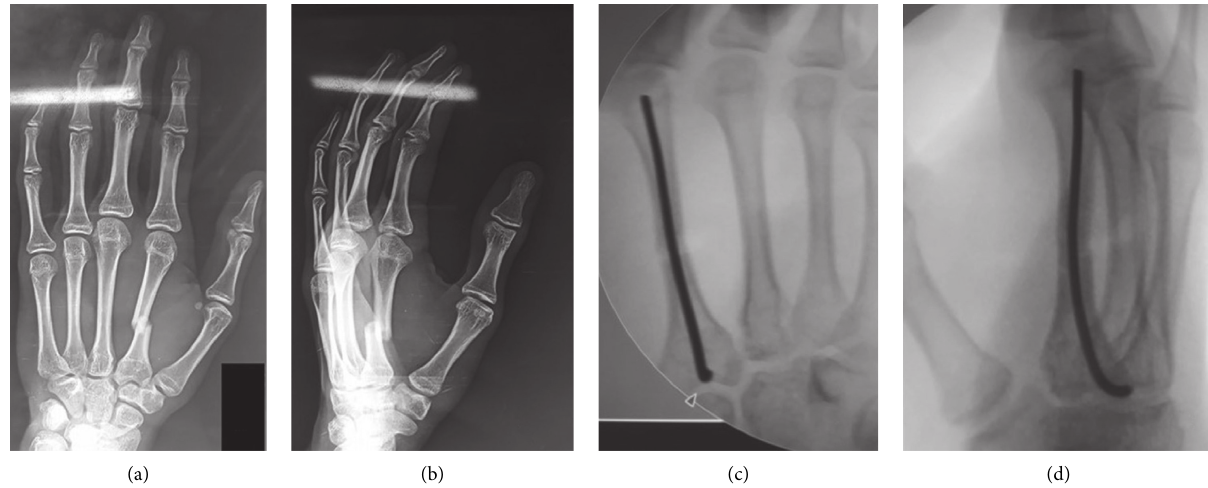
Figure 3: A 17-year-old male patient whose X-rays of anteroposterior and oblique views of the hand show a displaced diaphyseal fracture of the second metacarpal. Fluoroscopic photos show the final fixation of the displaced second metacarpal fracture with the three-point fixation of the intramedullary